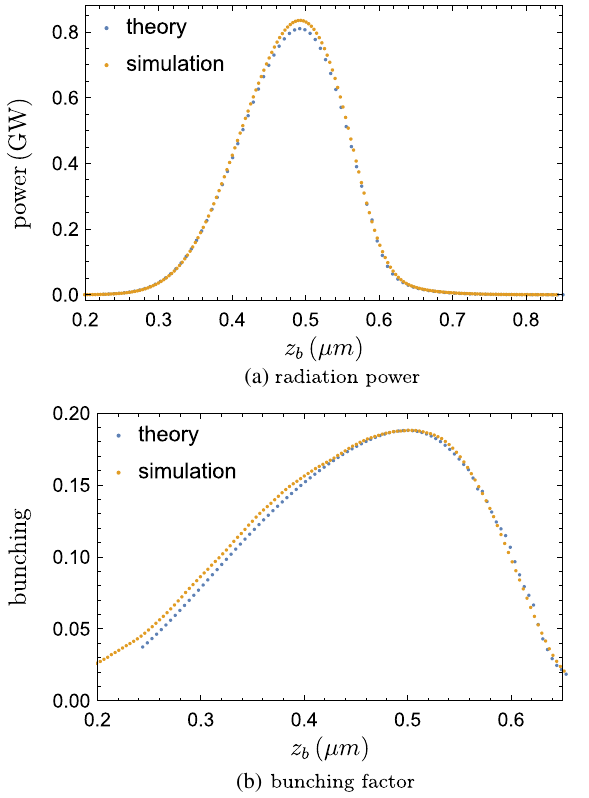
FIG. 3. Shot-averaged radiation power and bunching factor along the e-beam (case B: z ¼ 11 . 45 m, 0 . 75 μ m bunch length, σ ¼ σ 160 nm, Δ E ¼ 30 MeV, 400 shot average, θ =k r ¼ matched linear chirp). The blue/brown curves represent theory/ simulation